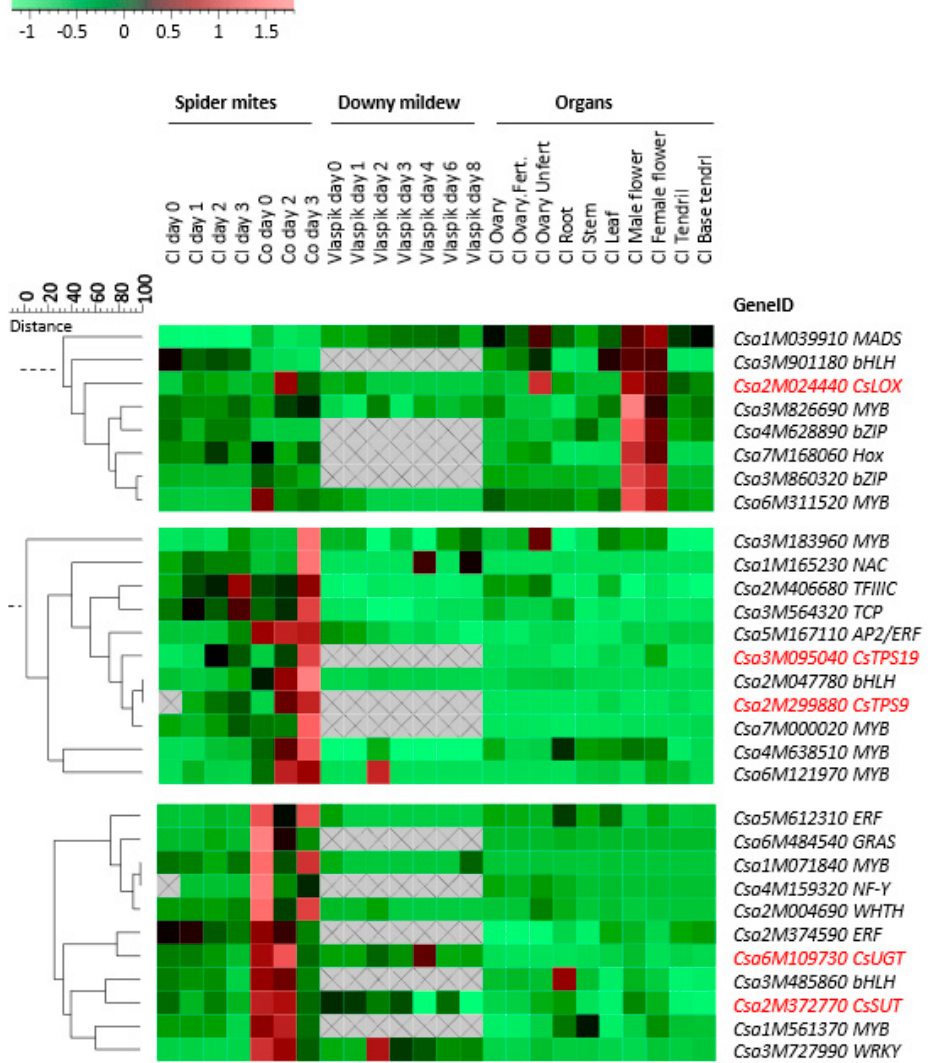
Figure 5. Co-expression of a selection of metabolism-associated genes (indicated in red font, CsLOX , CsTPS9 , CsTPS19 , CsUGT , CsSUT ) and TF genes during feeding by spider mites ( T. urticae ) [44], downy mildew ( p. cubensis ) [45] infection and in different non-infested/non-infected organs [12] of cucumber accessions Chinese long (Cl), Corona (Co) and Vlaspik. The scale indicates the distance of the similarity of the expression profile of these genes. Color coding: green represents low expression and red represents high expression. Grey areas with cross indicate that no transcripts were detected.